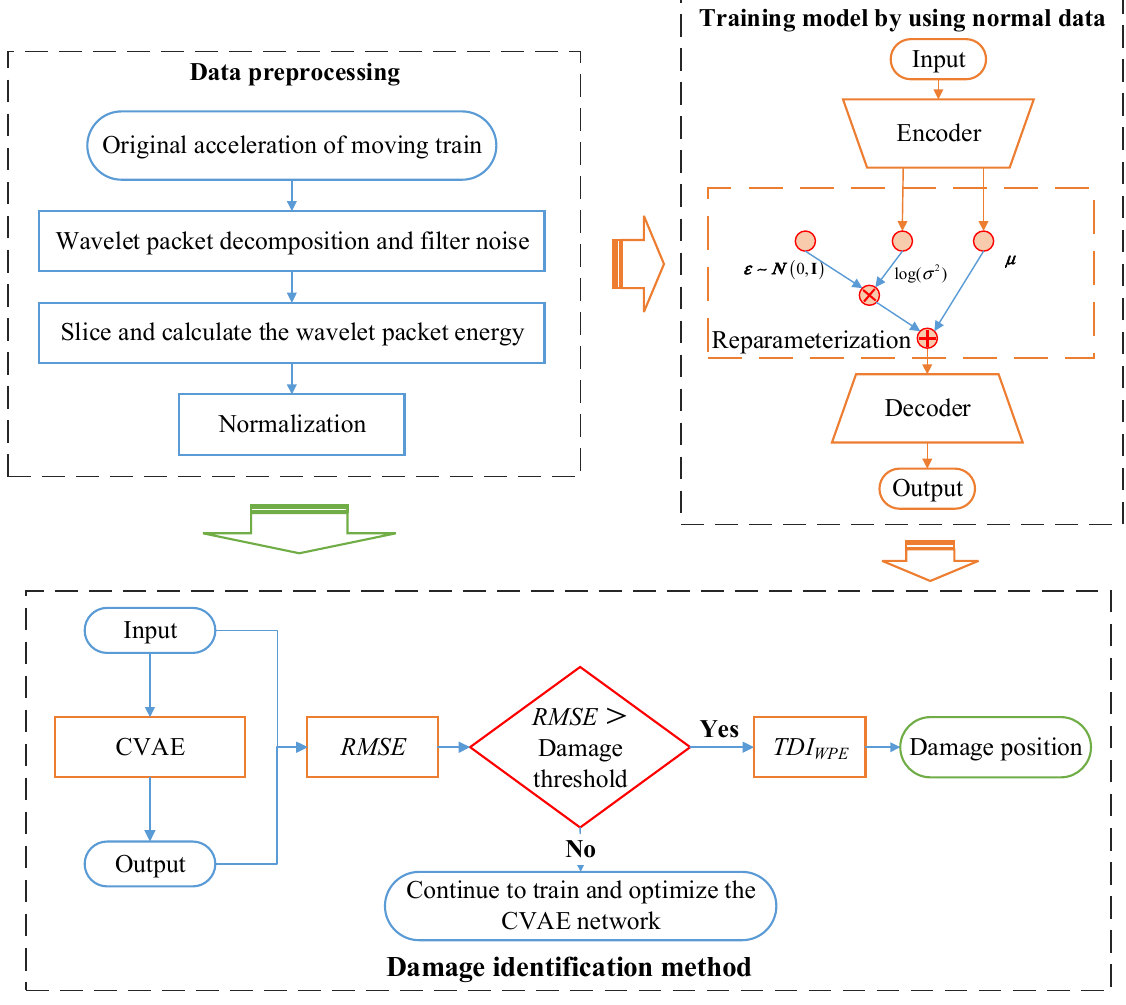
Figure 2. Framework of the proposed tunnel damage detection